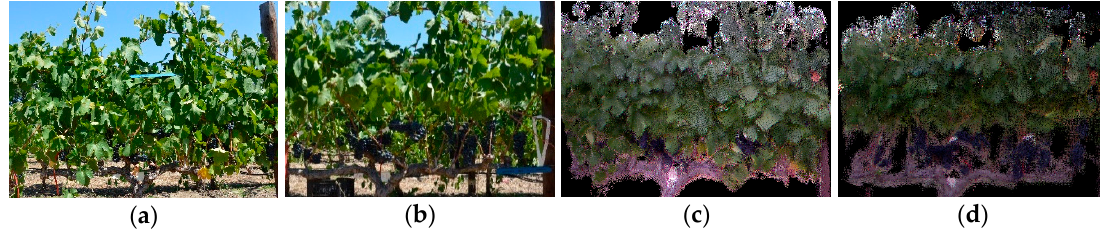
Figure 5. Experiment three data examples at plant-level. RGB imagery of FC ( a ) and LR ( b ) treatments. RGB-D (Kinect point cloud) of FC ( c ) and LR ( d ) treatments.